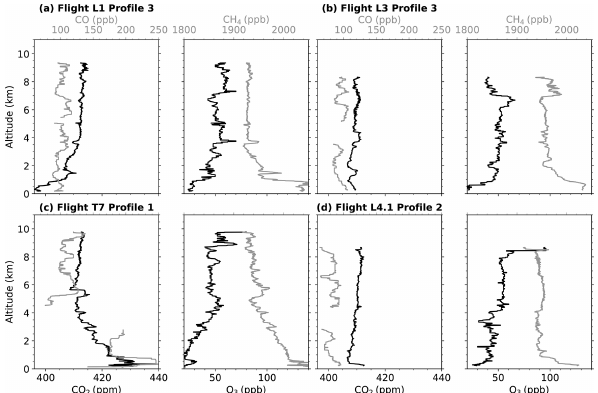
Figure 6. Four selected vertical profiles of the campaign. CO 2 and CO are respectively in black and gray on each left plot. O 3 and CH 4 are respectively in black and gray on each right